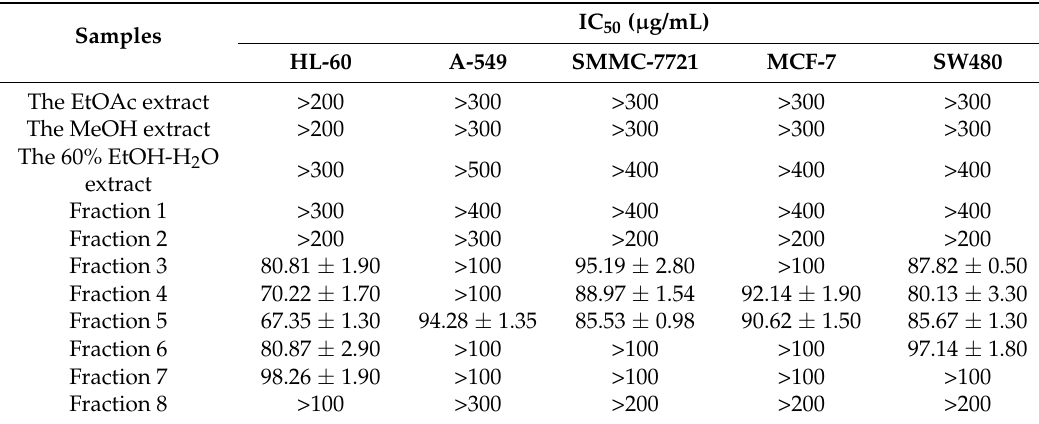
Table 3. Cytotoxic activities of column chromatography fractions.